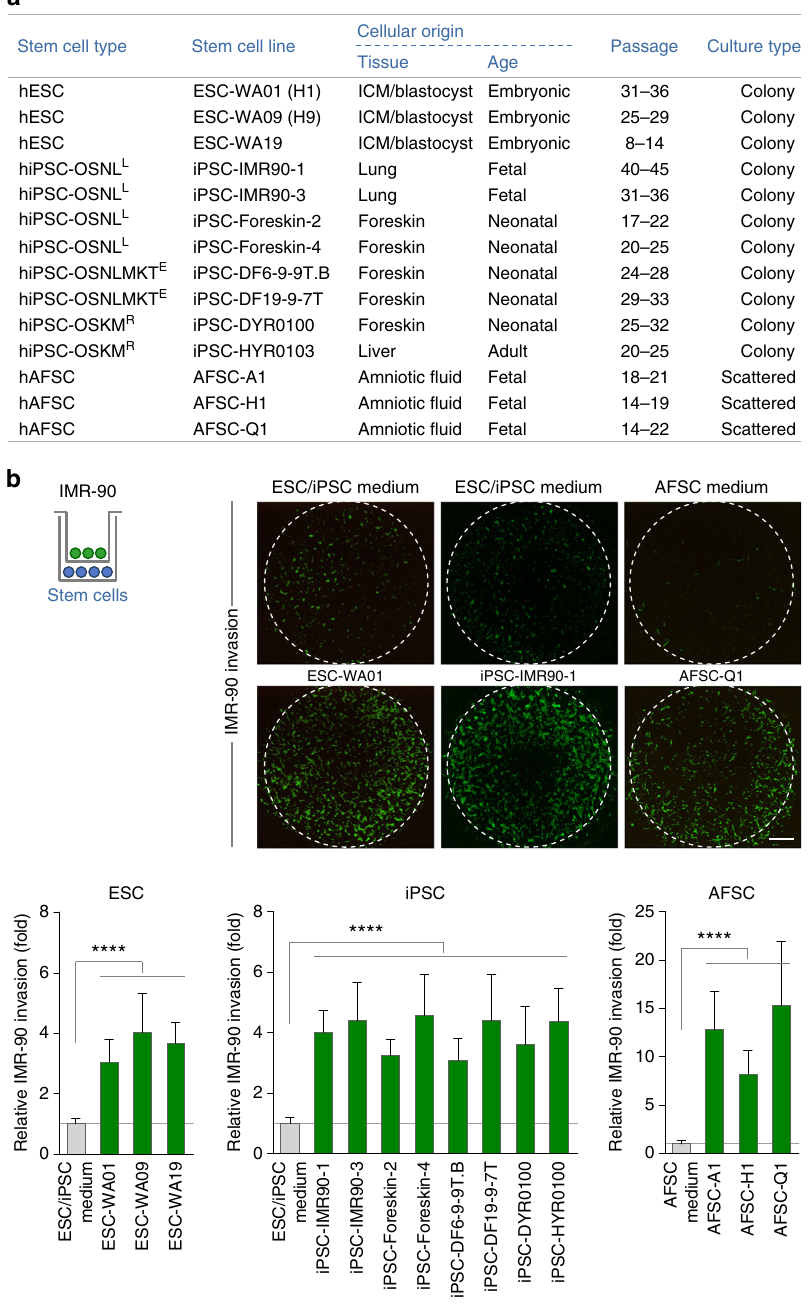
Fig. 1 Human stem cells induce the invasion of primary fi broblasts. a Human embryonic (ESC), induced pluripotent (iPSC) and amniotic fl uid (AFSC) stem cells analysed in this study. Passage numbers indicate the range within which experiments were performed. OSNL L , OCT4, SOX2, NANOG, LIN28, lentiviral transduction; OSNLMKT E , OCT4, SOX2, NANOG, LIN28, c-MYC, KLF4, SV40LT, episomal transduction; OSKM R , OCT4, SOX2, KLF4, c-MYC, retroviral transduction. b Transwell invasion assay of IMR-90 fi broblasts co-cultured with ESCs, iPSCs or AFSCs. Pictures show representative Calcein-stainings of invasive IMR-90 cells upon stem cell co-culture. Data are presented as the fold change of the corresponding medium control ( n ≥ 6; mean ± s.d.). Scale bar , 800 μ m. **** P < 0.0001 by unpaired, two-tailed Student ’ s t -test analysis. n refers to biological